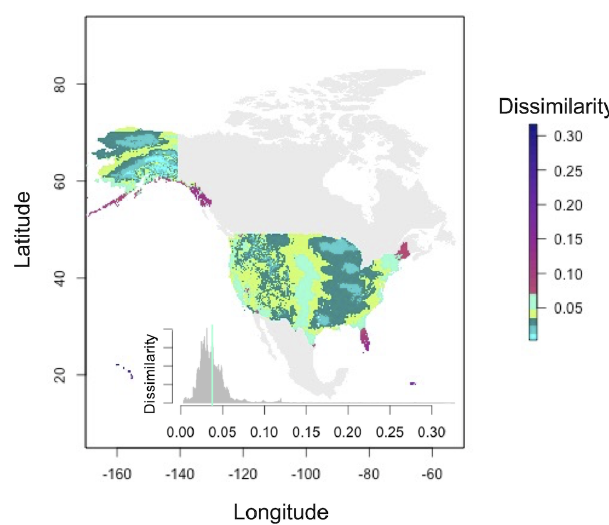
Figure 3. Cluster dissimilarity for the US. Inset: the distributions of dissimilarity across all clusters shown in a histogram, in which the line denotes the mean dissimilarity across all